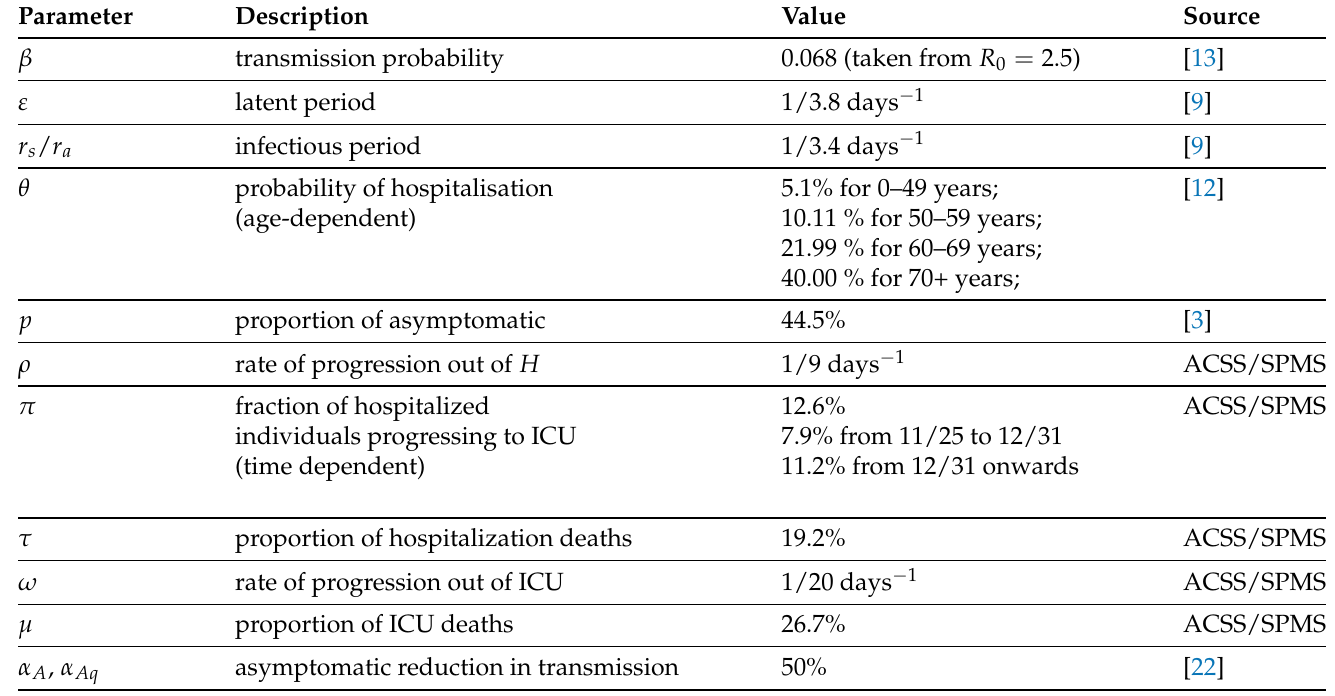
Table A1. Description, value and source for the parameters used in the